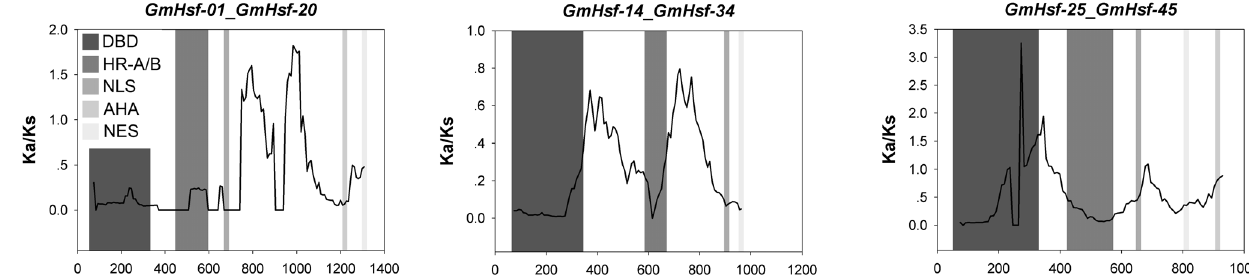
Figure 6. Sliding window plots of representative duplicated Hsf genes in G.max . As shown in the key, the gray blocks, from dark to light, indicate the positions of the DBD domain, HR-A/B region, NLS, NES and AHA motifs, respectively. The window size is 150 bp, and the step size is 9 bp. The data for all pairs of duplicated Hsf genes of soybean are shown in Figure S6. doi:10.1371/journal.pone.0102825.g006 PLOS ONE |